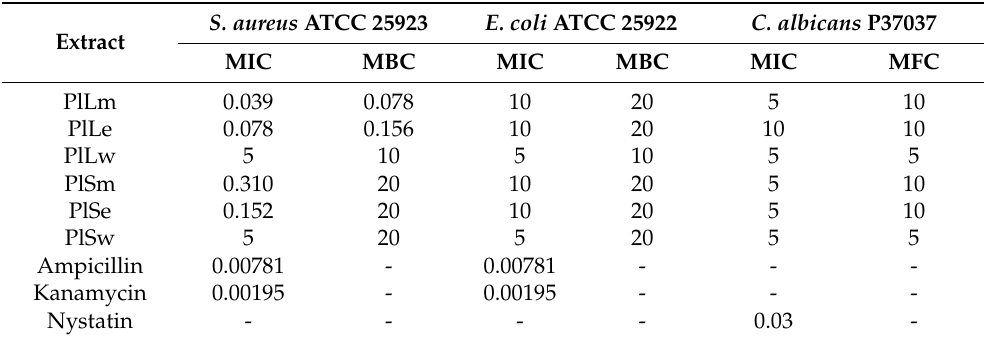
Table 1. Minimum inhibitory concentration and minimum bactericidal/fungicidal concentration of P. longifolia extracts